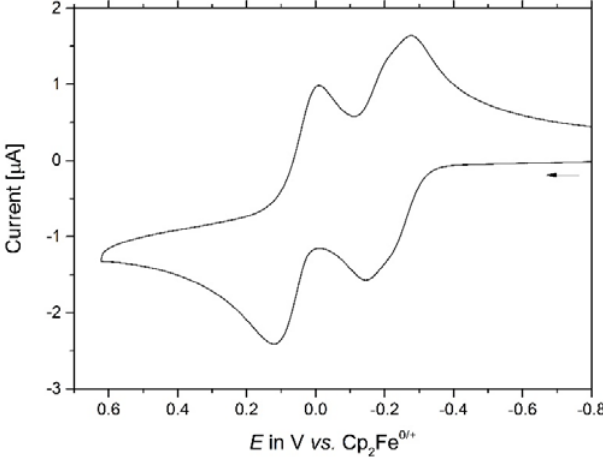
Figure 6. Cyclic voltammogram of macrocycle 3 (CH 2 Cl 2 , NBu 4+ PF 6 − , 0.1 M, at v = 100 mV/s, r.t. diruthenium reference complexes Ru 2 Cl 2 and Ru 2 bza 2.